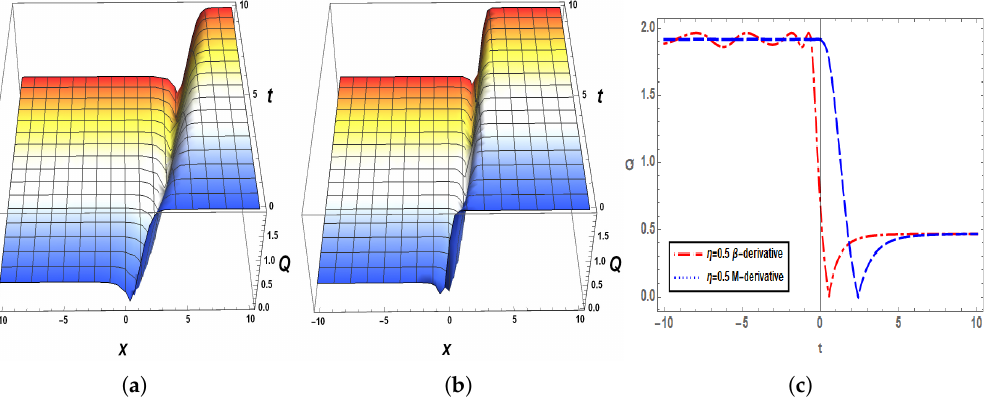
Figure 2. For Q 4,1 ( x , t ) , we take µ = 0.1, γ = − 0.1, σ = 2, θ = 0.5, ϑ = 1, (cid:101) = 2, C = − 1, and λ = 1. ( a – c ) reflect the 3 D and 2 D graphs employing η = 0.5 at t =